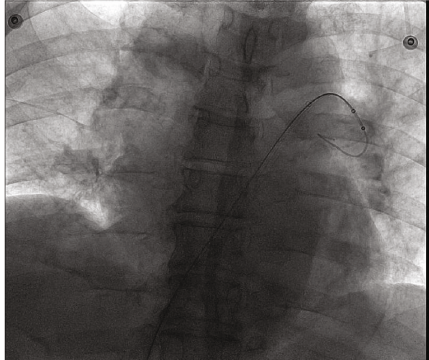
Figure 2: Angiographic imaging of Angiojet system in the fi rst